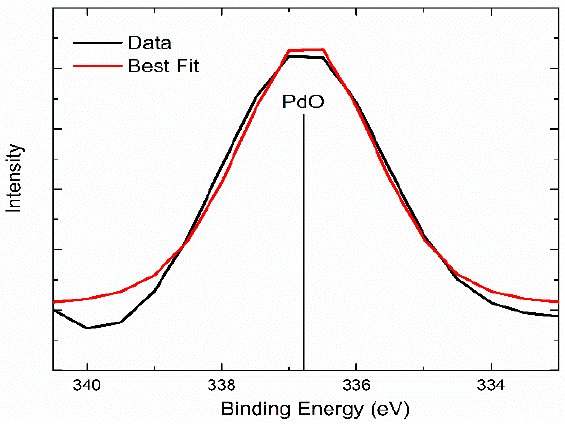
Figure 13. XPS (Pd3d 5/2 peak) of calcined Pd (II) nitrate.